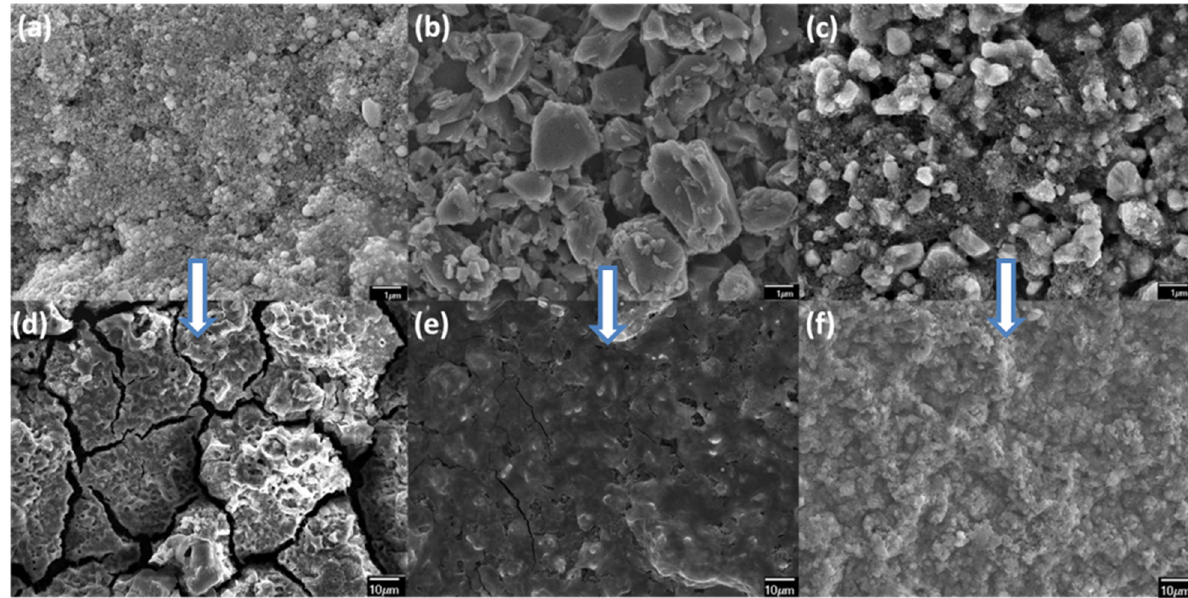
Figure 1. Typical SEM images of electrodes based on ( a ) pure-Si; ( b ) pure-LTO and 50LTO20Si before the electrochemical test ( a – c ) and after the electrochemical test ( d – f ),